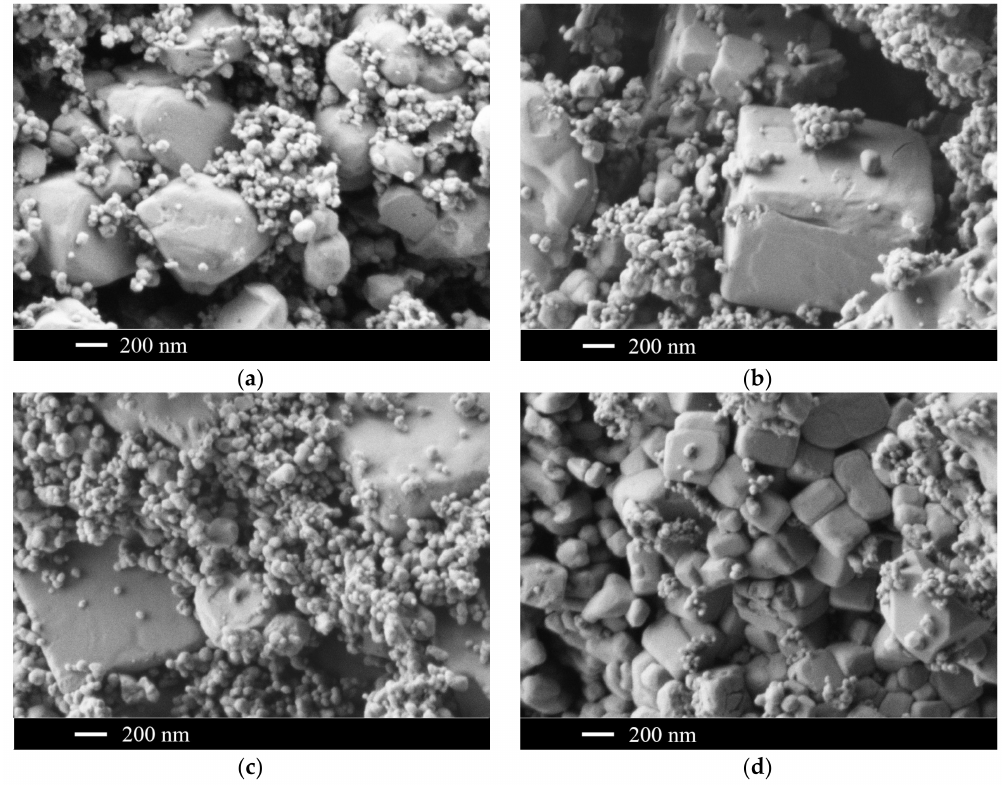
Figure 10. SEM images of CaF 2 –SrF 2 (1:1) samples prepared at 300 ◦ C and M(NO 3 ) 2 :NaF:NaNO 3 (M = Ca + Sr) ratios of starting materials (mol %): 22:33:45 (sample 17) ( a ); 8:12:80 (sample 18) ( b ); 17:50:33 (sample 19) ( c ); and 7:21:72 (sample 20) ( d